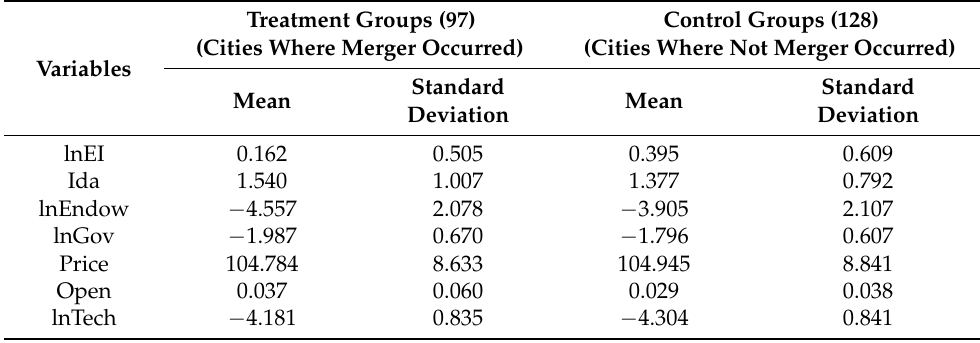
Table 1. Descriptive statistics of the main